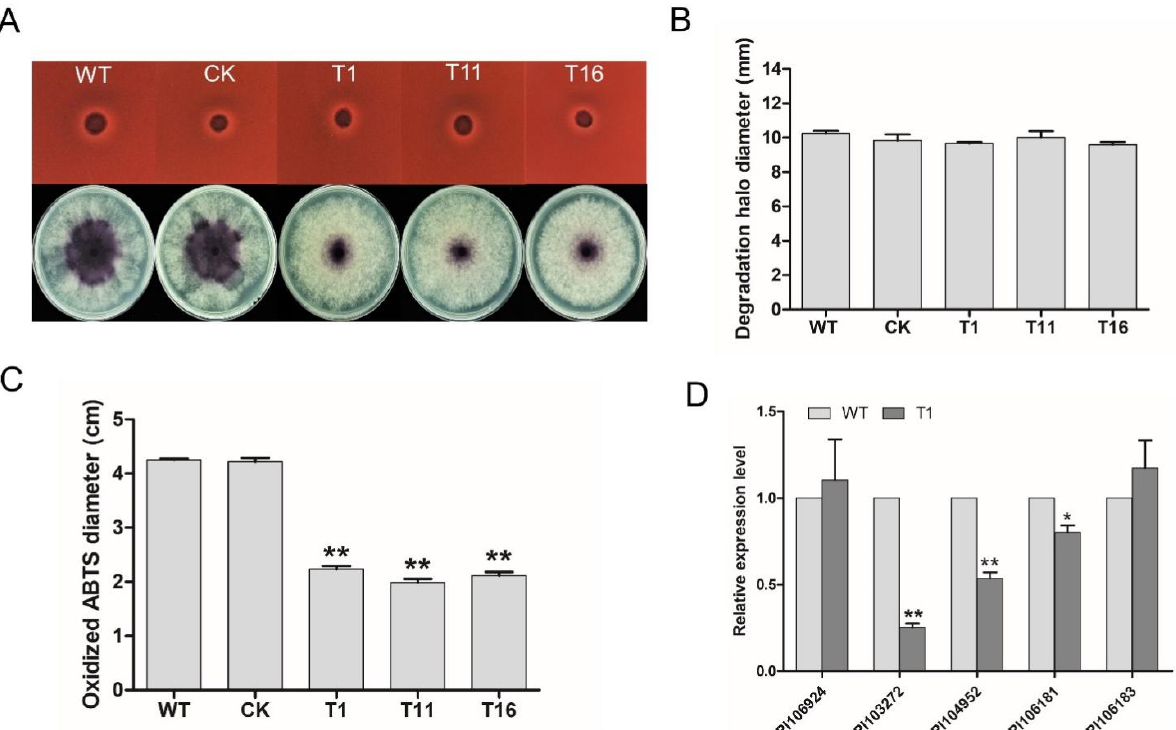
Figure 8. Detection of extracellular peroxidase and laccase activity in PlCZF1 deletion mutants. ( A ) Peroxidase and laccase activity assay. For peroxidase activity assay, mycelial mats of WT, CK and three PlCZF1 deletion mutants were inoculated onto solid Plich medium containing Congo red at a final concentration of 500 g/mL for 1 day; For laccase activity assay, mycelial mats of the aforementioned strains were inoculated on lima bean agar (LBA) media containing 0.2 mM ABTS for 10 days. ( B ) The discoloration halo diameters were measured at 1 day post-inoculation. ( C ) The diameters of oxidized ABTS (dark purple) were measured at 10 days post-inoculation. Different letters bar charts represent a significant difference ( p < 0.05) based on Duncan’s multiple range test method. These experiments contained three independent biological repeats, each of which contained three replicas. ( D ) The transcript levels of putative peroxidase-encoding genes and laccase-encoding genes in T1 and WT strain. The constitutive expression of PlActin was used as a reference gene. Data represent means ± SD from three independent biological repeats, and asterisks denote significant differences from the control group (Student’s t -test: * p < 0.05; ** p < 0.01). Additionally, we also examined the transcription of putative laccase encoding